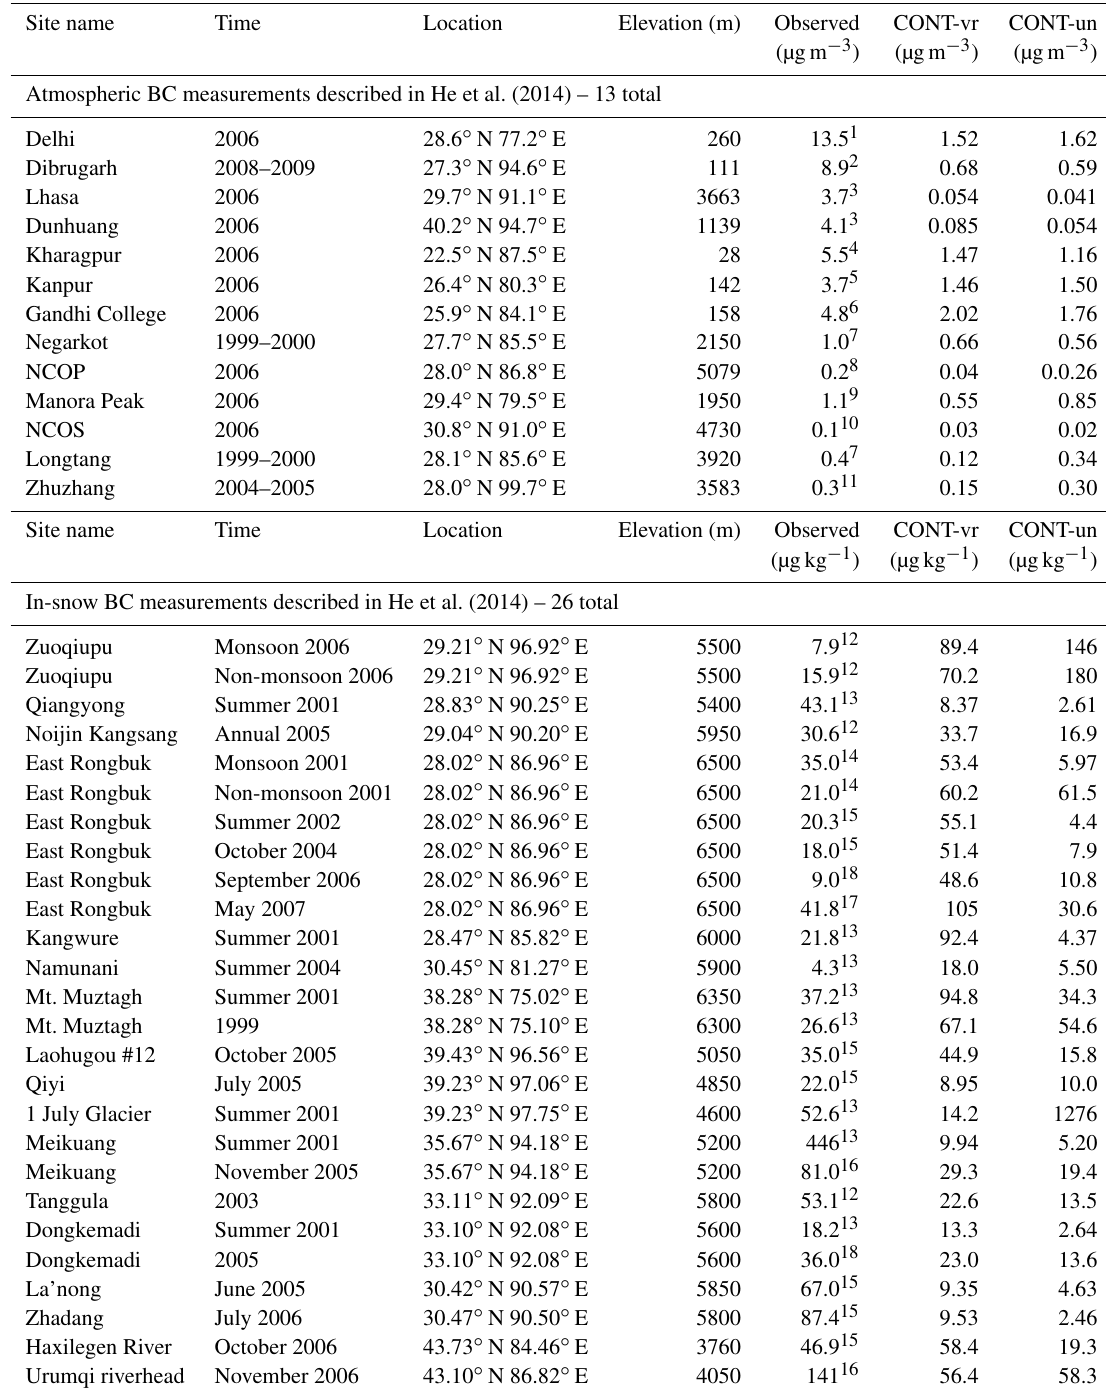
Table 2. Listing of metadata for the point source BC measurements used in this study. CONT-vr and CONT-un results are also shown. The superscript attached to the observed value denotes the following citations. 1 Beegum et al. (2009). 2 Pathak et al. (2010). 3 Zhang et al. (2008). 4 Nair et al. (2012). 5 Ram et al. (2010b). 6 Ganguly et al. (2009b). 7 Carrico et al. (2003). 8 Bonasoni et al. (2010). 9 Ram et al. (2010a). 10 Ming et al. (2010). 11 Qu et al. (2008). 12 Xu et al. (2009). 13 Xu et al. (2006). 14 Ming et al. (2008). 15 Ming et al. (2009a).